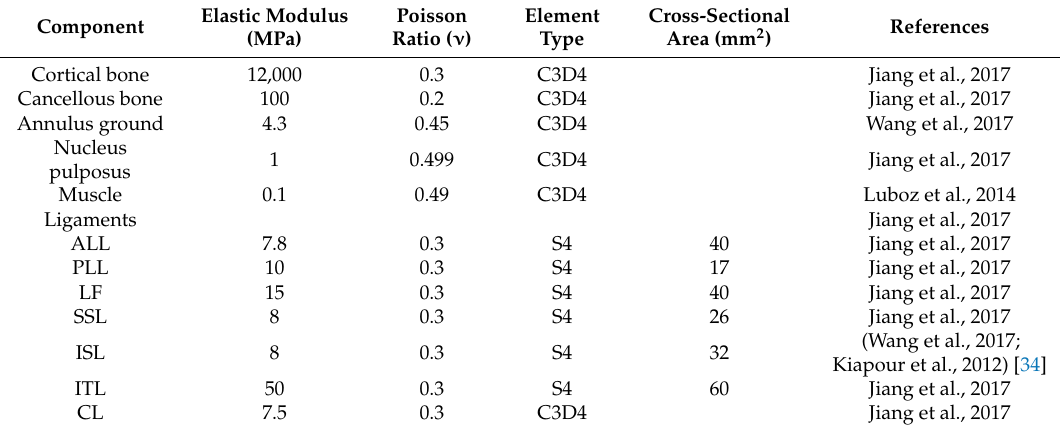
Table 2. Properties of model